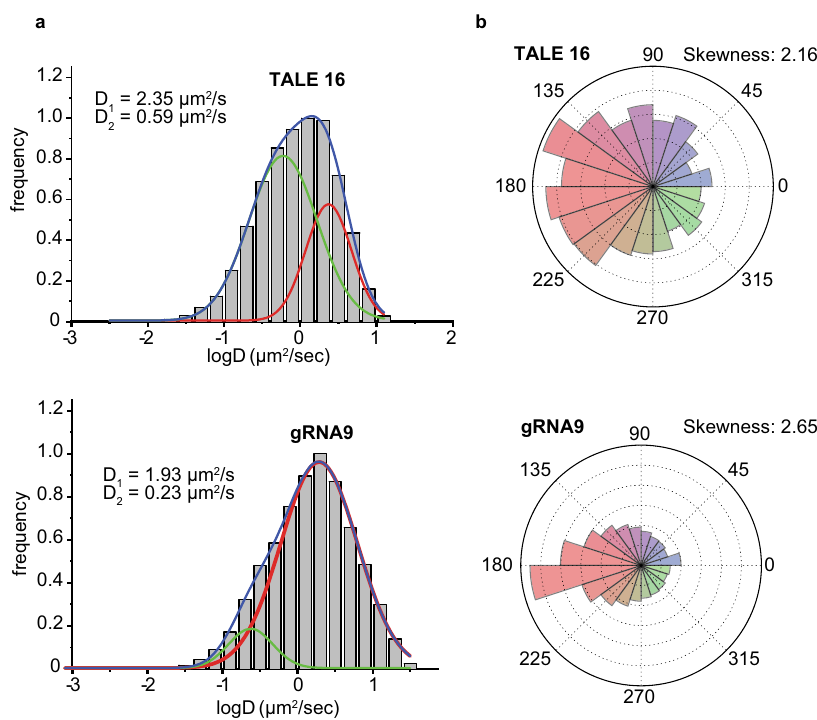
Fig. 4 Comparison of TALE and dCas9 search dynamics in a heterochromatin locus. a Multi-peak Gaussian fi tting of normalized diffusion coef fi cient distribution reveals that the bimodal search behavior in heterochromatin is similar to that in euchromatin, but dCas9 kinetics is overall slower than TALE kinetics. N TALE 16 = 21647 and N CFTR Cas9 = 9424, where N denotes the number of data points. b Pointedly skewed angular distribution curve of gRNA9 demonstrates that its motion is highly constricted in heterochromatin. N TALE 16 = 1217 and N CFTR Cas9 = 22,800. Source data are provided as a Source Data fi